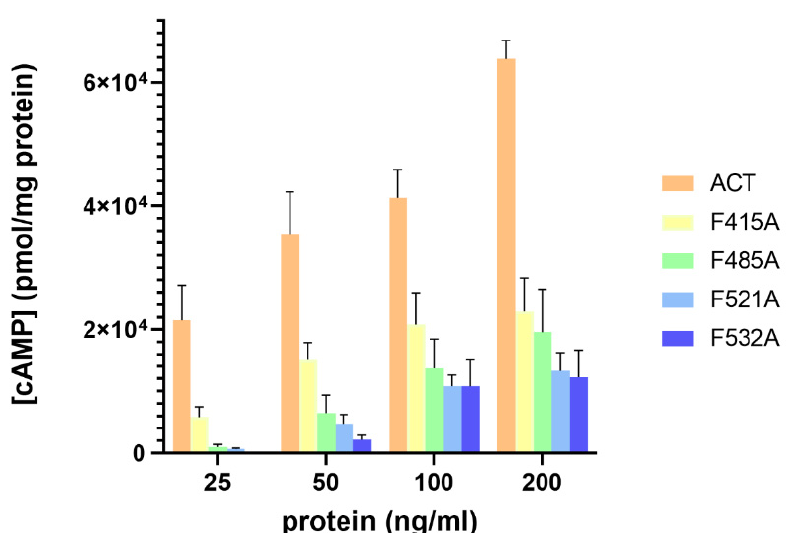
Figure 9. Point Ala substitutions in the central Phe residue of the potential cholesterol-binding sites CRAC 415 , CARC 485 , CRAC 521 and CARC 532 prominently decrease AC domain translocation. Translocation of AC domain was assessed by determining the intracellular concentration of cAMP (pmol/mg protein), generated in J774A.1 cells (1 × 10 5 cells/mL) suspended in 20 mM Tris-HCl, pH = 8.0 buffer, supplemented with 150 mM NaCl and 2 mM CaCl 2 . Cells were treated for 30 min at 37 °C with different concentrations (25–200 ng/mL) of intact ACT, or the corresponding mutant toxin. Data represent the mean ± SD of at least three independent experiments.